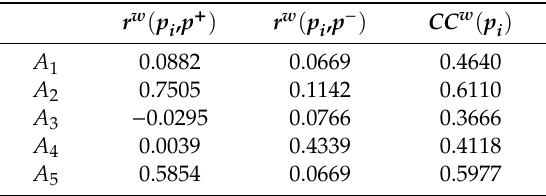
Table 2. Computational